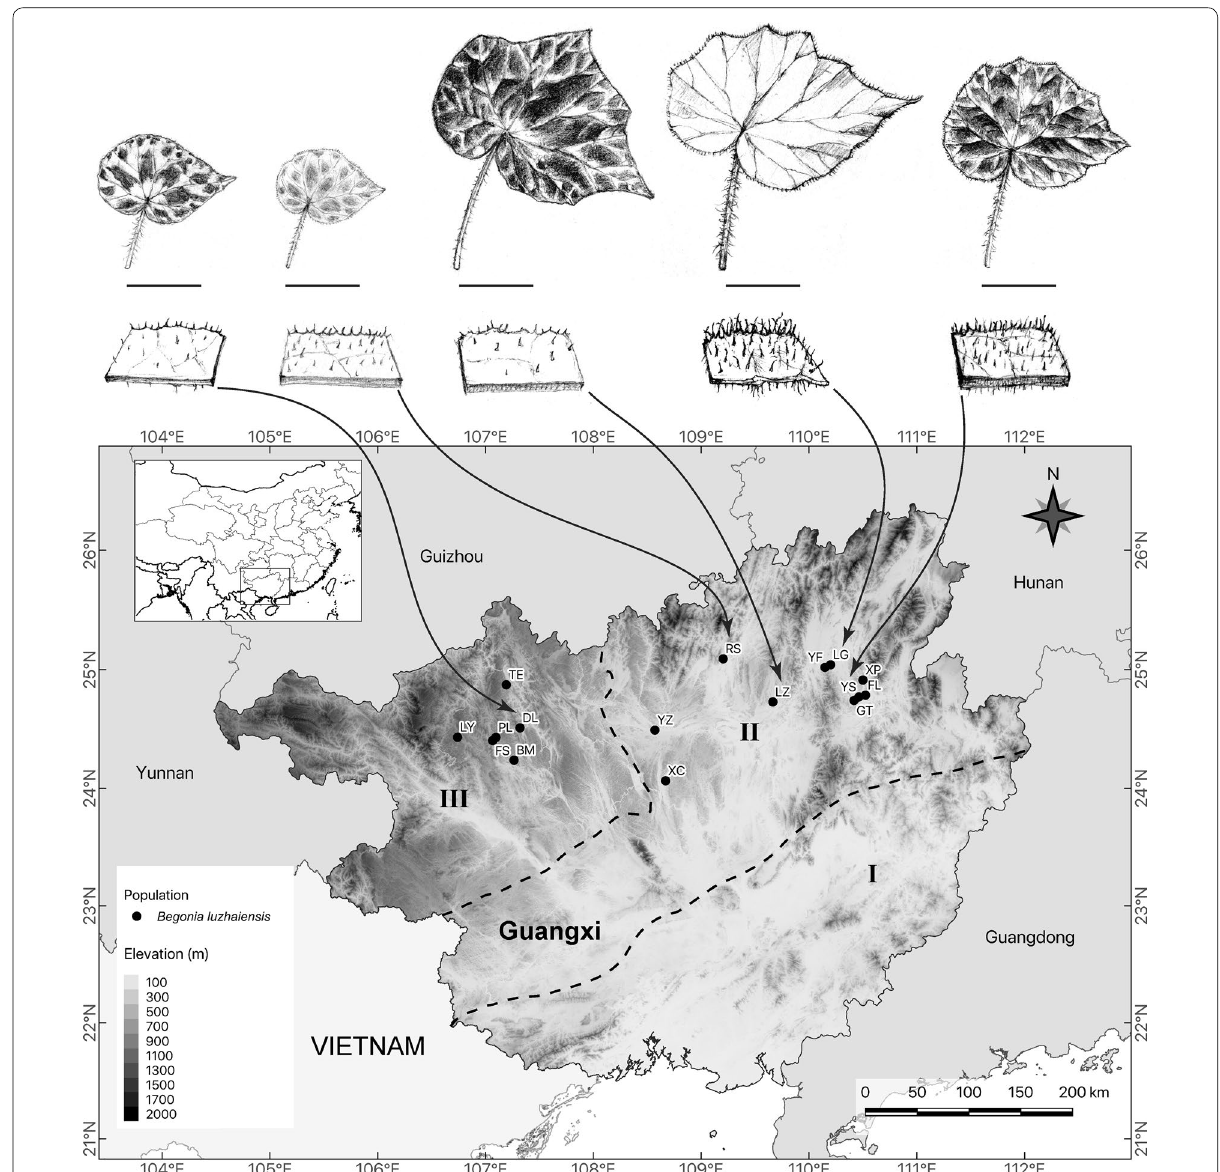
Fig. 2 Sampling sites and leaf variation of Begonia luzhaiensis . Dash lines demarcate Liu et al. (2001)’s classification of Guangxi’s karst landforms: (I) karst plain, (II) Fenglin plain, and (III) Fengcong depression. Scale bar